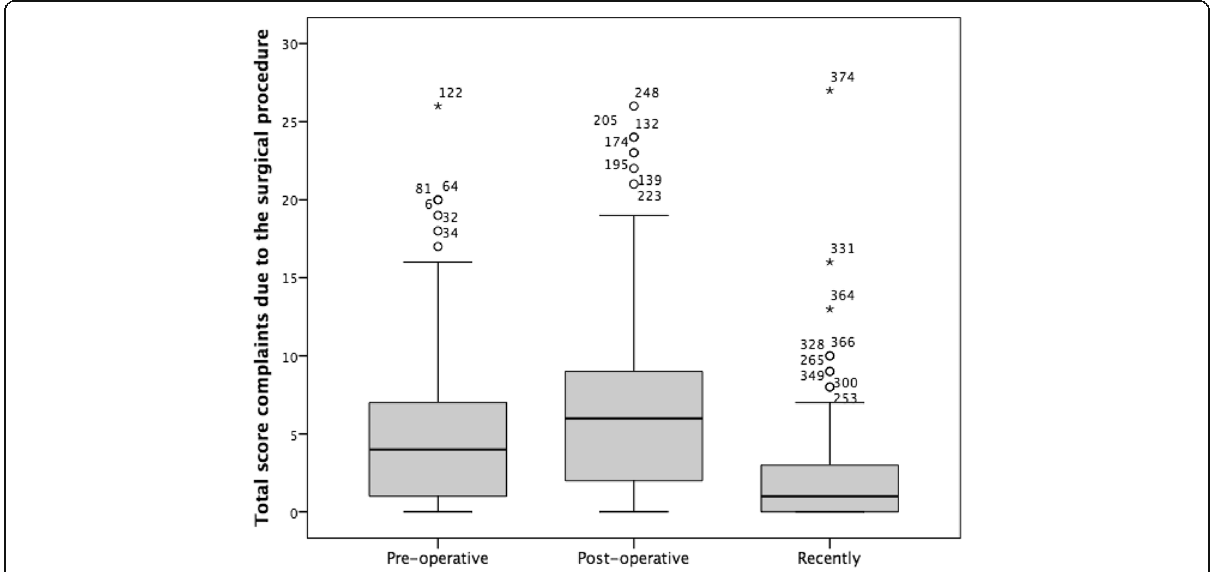
Fig. 3 Total score for complaints due to surgical procedure pre-operative, post-operative, and recently